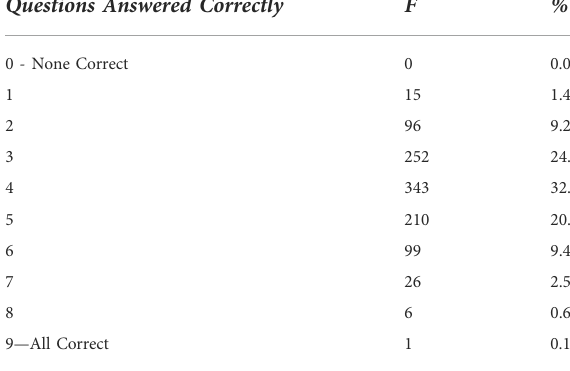
TABLE 4 Knowledge of environmental changes test score (N =